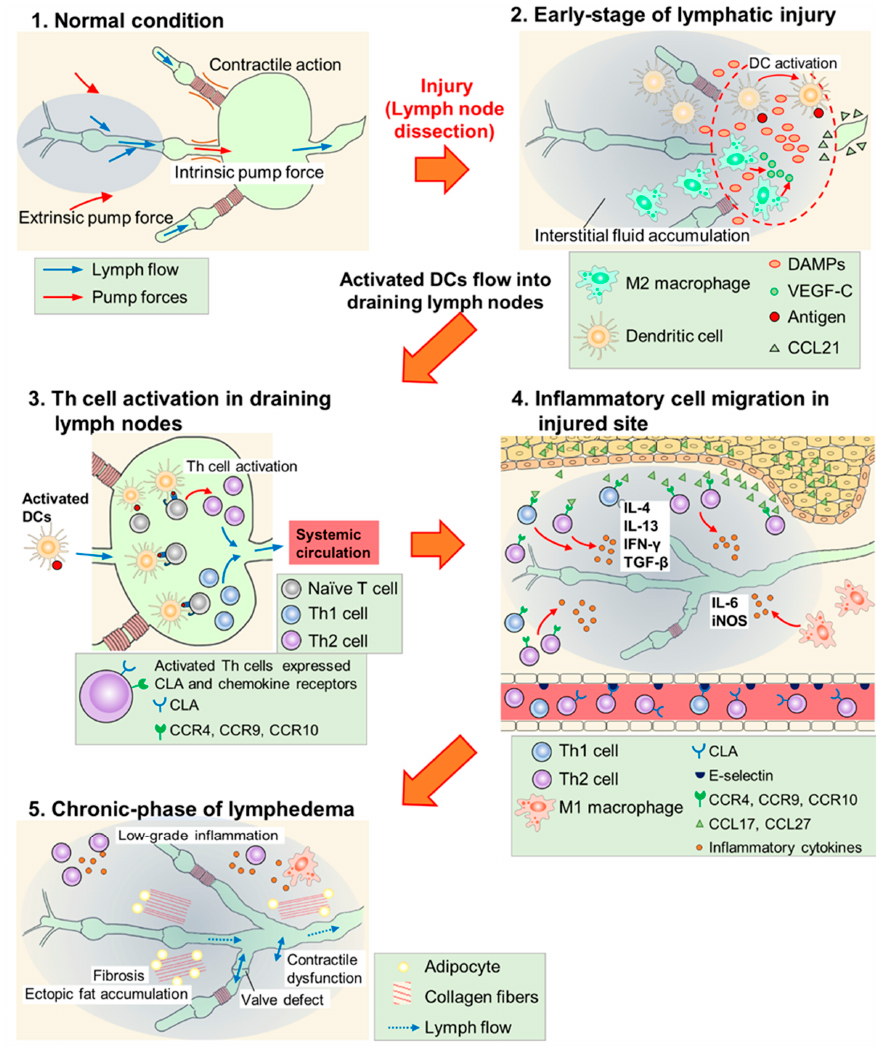
Figure 1. Scheme of lymphedema development after lymph node dissection. ( 1 ) In normal conditions, lymph flow is generated due to intrinsic pump force by a lymphatic collecting vessel network and extrinsic pump force by surrounding skeletal muscles. ( 2 ) In the early phase of lymphatic injury, damage-associated molecular patterns (DAMPs) are released from injured cells and these molecules promote lymphangiogenesis. M2 macrophages secrete vascular endothelial growth factor C (VEGF-C) and serve as lymphatic endothelial cell (LEC) progenitors. Dendritic cells (DCs) are activated at the injured site, and invade into lymphatic vessels along the concentration gradient of the C–C chemokine ligand (CCL) 21 secreted by LECs. ( 3 ) Activated DCs flow into draining lymph nodes and activate helper T (Th) cells. Expressions of cutaneous leukocyte antigen (CLA), C–C chemokine receptor (CCR) 4, CCR9, and CCR10 are increased at the surface of activated Th cells. These cells enter systemic circulation. ( 4 ) Activated Th cells, guided by adhesion molecules and CCLs, infiltrate the injured site and secrete inflammatory cytokines. M1 macrophages also accumulate at the injured site and cause inflammatory responses. ( 5 ) Low-grade inflammatory responses, fibrosis, adipose deposition, and unfunctional lymphangiogenesis (valve defect and contractile dysfunction) occur in the chronic phase of lymphedema. These responses impair lymphatic function and exacerbate lymphedema. In this early phase, DCs accumulate in the injured skin and activate acquired immu- nity [25]. The expression of C–C chemokine receptor (CCR) type 7 increases on the surface of activated DCs, which migrate according to the concentration gradient of C-C chemokine ligand (CCL) type 21 secreted by LECs. Furthermore, after reaching the lymphatic